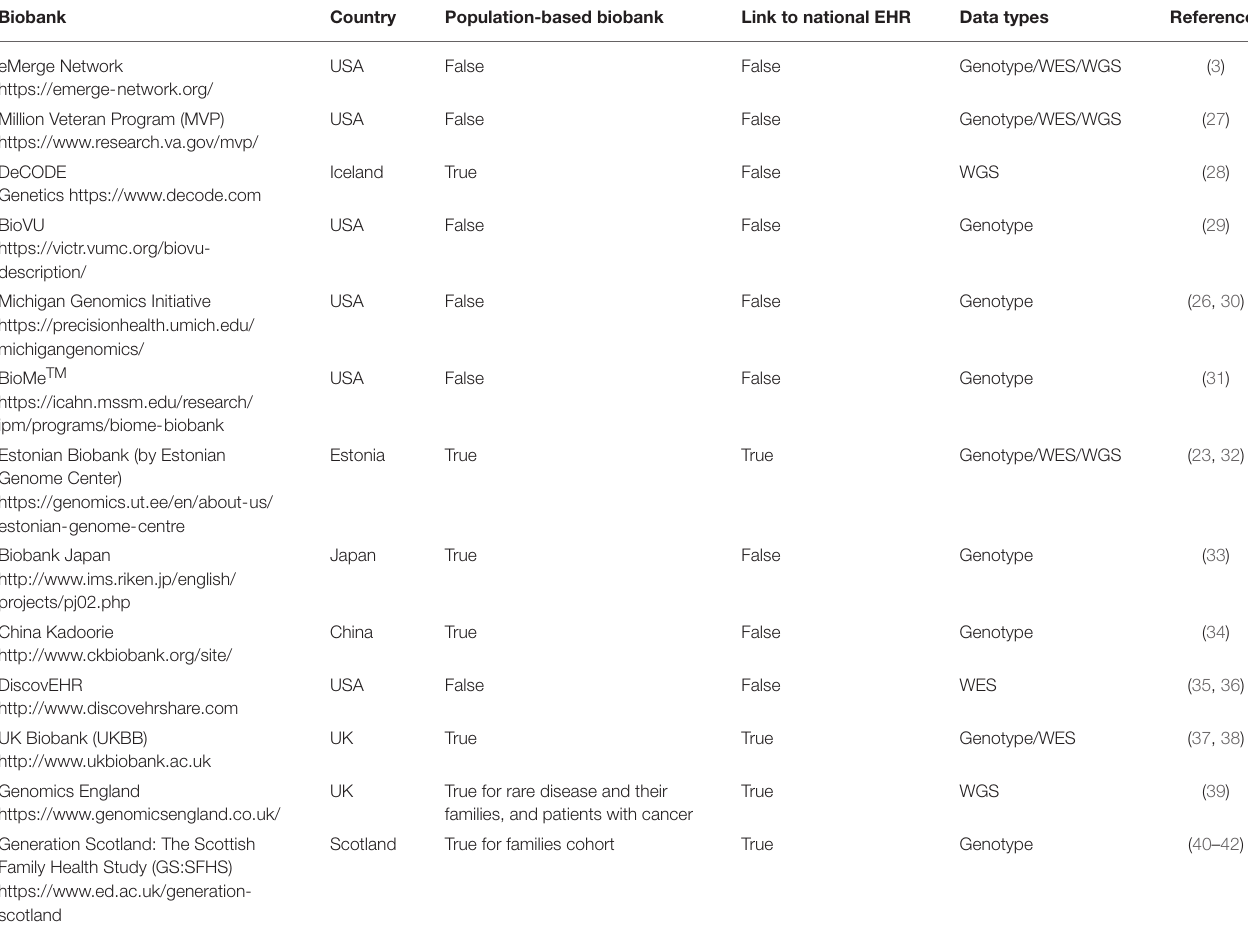
TABLE 1 | A selection of major biobank schemes that work with EHRs. Biobank Country Population-based biobank Link to national